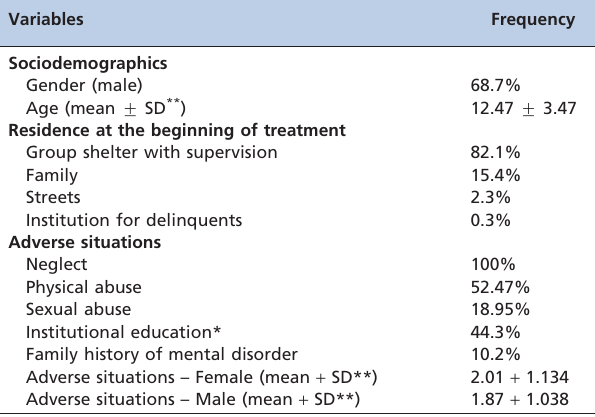
Table 1 - Sociodemographic characteristics and adverse situations of children/adolescents with social